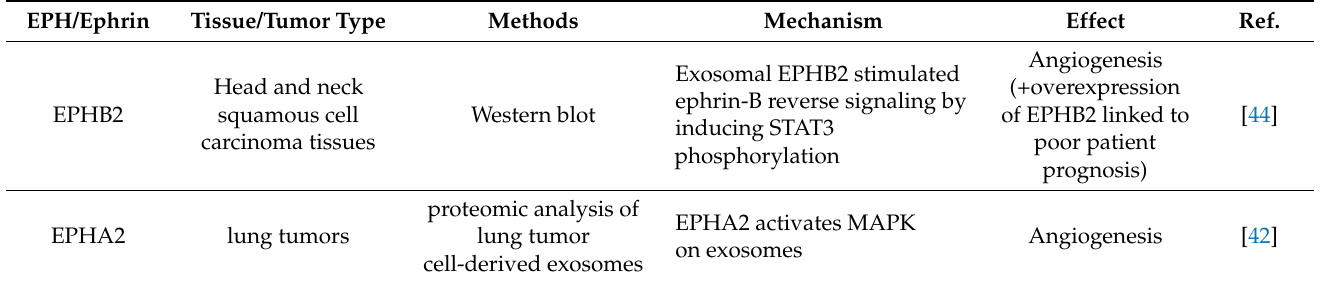
Table 1. Delineating the mechanism of action and the effect of exosomal EPHs in various disease settings. EPH/Ephrin Tissue/Tumor